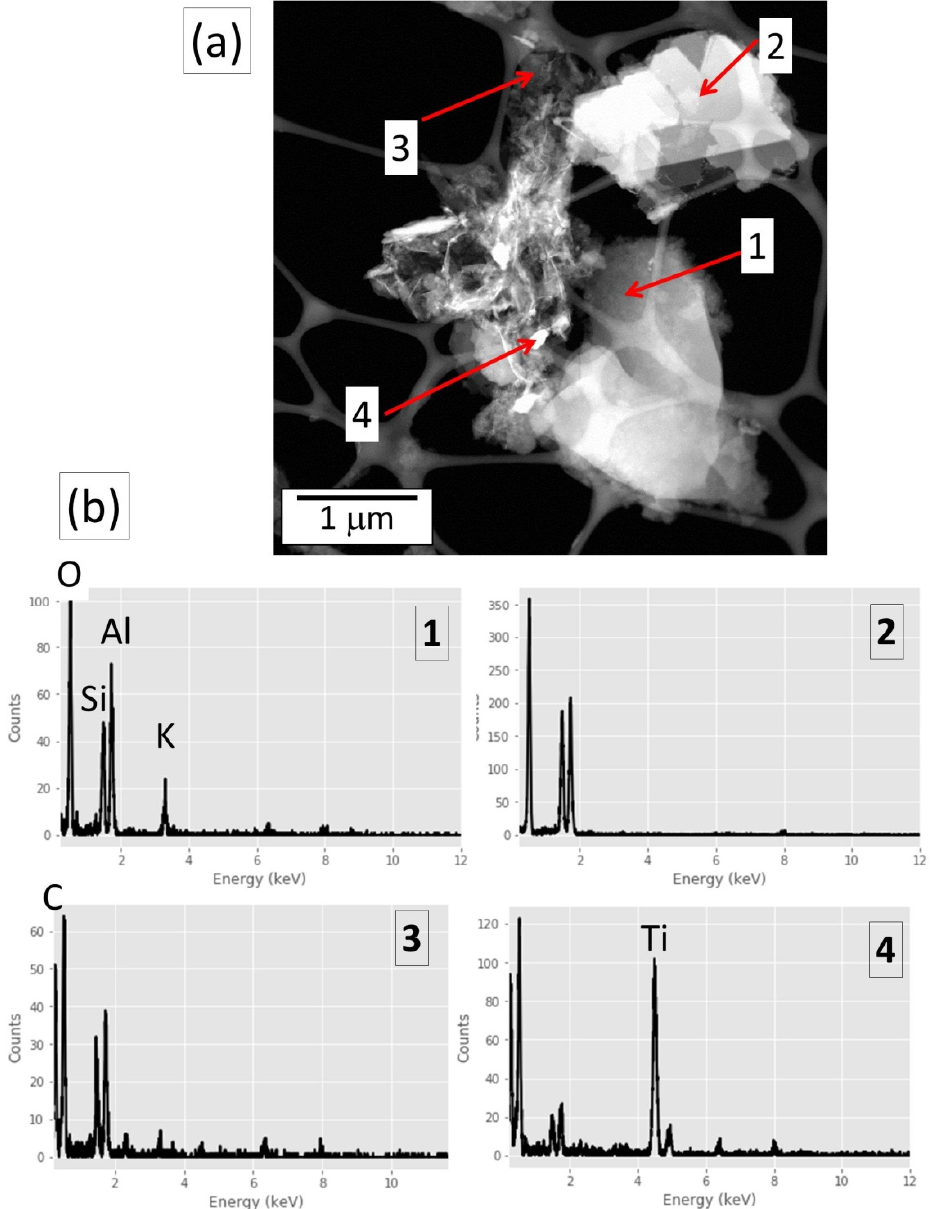
Figure 3. ( a ) ADF-STEM images, ( b ) spatially-resolved EDX spectra of the sub-2 µm total clay fraction of the contaminant solids. The locations for the EDX spectra in ( b ) are labelled in ( a ).